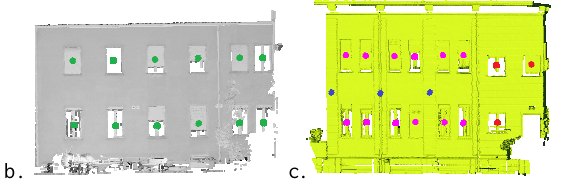
Figure 8. Results of RSD algorithm. Notice the reconstruction of fully occluded windows (a) and the satisfactory performance in low resolution regions (b-c).